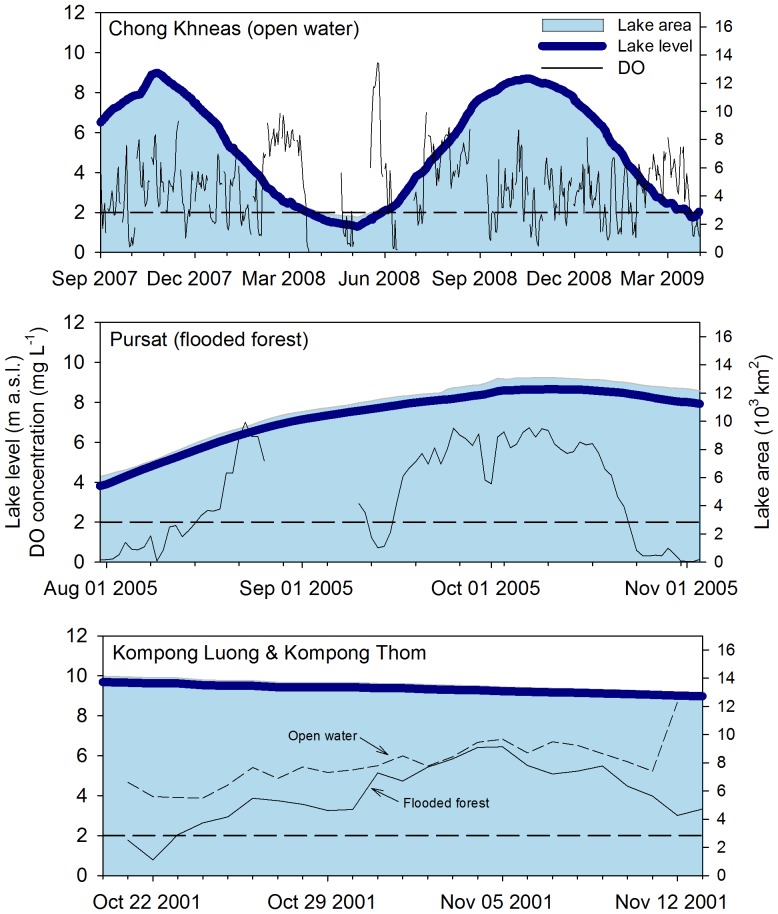
Continuous records of daily average dissolved oxygen concentration in the Tonle Sap lake and floodplain.The horizontal dashed line at 2 mg L−1 indicates hypoxic conditions at the sampling depth. Also shown are lake level and modeled lake area as described in Figure 1.